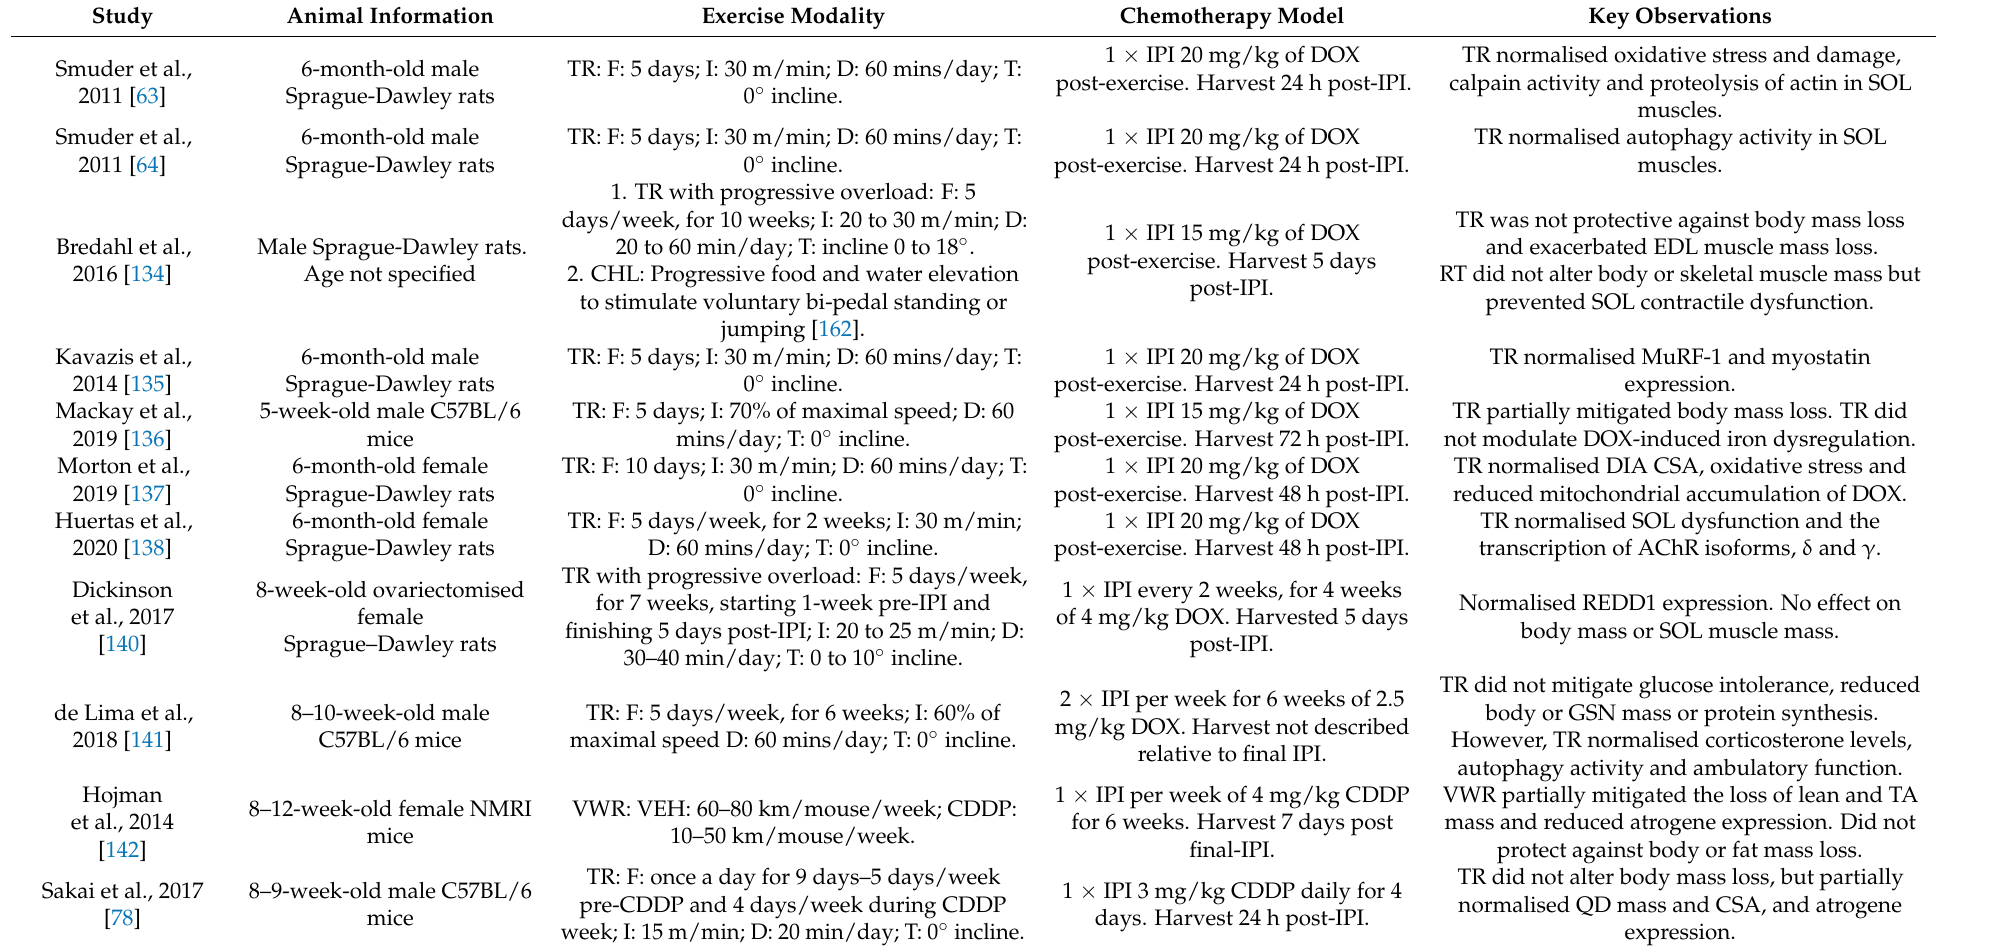
Table 1. Experimental studies on the effect of exercise against chemotherapy-induced cachectic